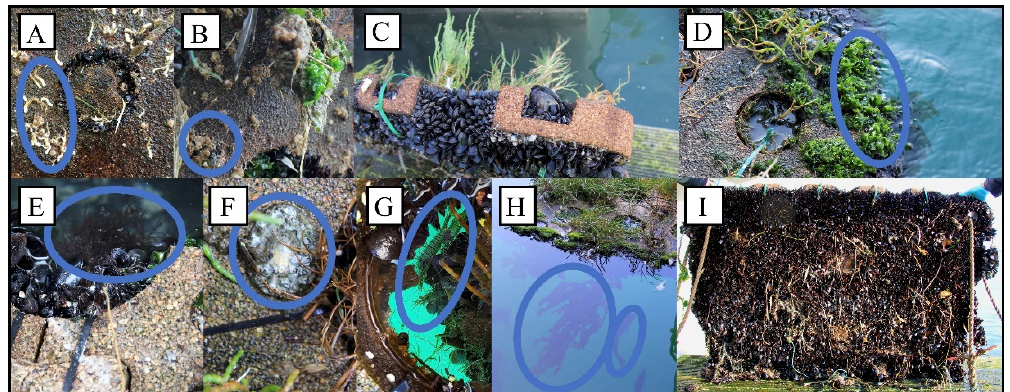
Figure 4. Macrofauna found on or surrounding the floating wetland island: (A) Polychaeta; (B) ( B ) Chthamalus sp.; ( C ) Mytilus sp.; ( D ) Ulva sp.; ( E ) Ceramium sp.; ( F ) Patella sp.; ( G ) Palaemon sp.; Chthamalus sp.; (C) Mytilus sp.; (D) Ulva sp.; (E) Ceramium sp.; (F) Patella sp.; (G) Palaemon sp.; (H) ( H ) Laminaria sp. (left elypse) and Mugil sp. (right elypse); ( I ) Mytilus Laminaria sp. (left elypse) and Mugil sp. (right elypse); (I) Mytilus sp.